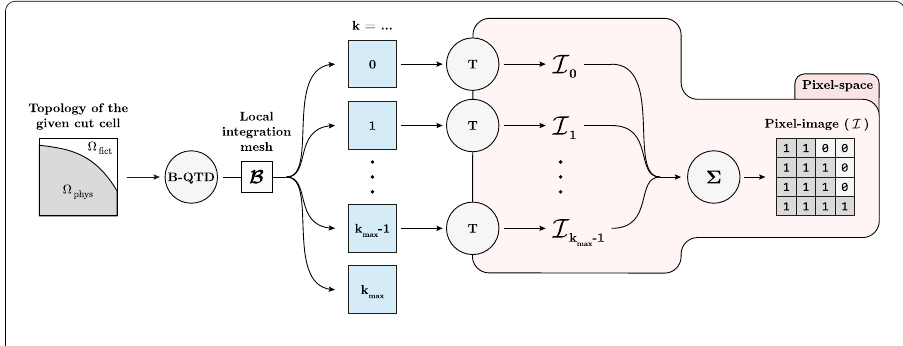
Fig. 17 Procedure of compressing the sub-cells on the layers k = 0 , 1 ,...,k max − 1 resulting from the B-QTD. The layers are transformed to the corresponding pixel-images I 0 , I 1 ,..., I k resolution 2 k max − 1 × 2 k max − 1 . After the final pixel image is created, the procedure is identical to the one depicted in Fig.